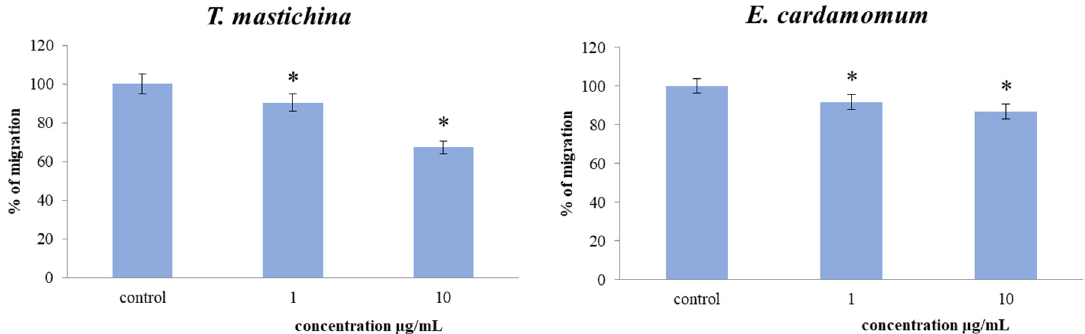
Figure 4. Effect of exposure to investigated essential oils on migration index of MDA-MB-468 cells. The cells were treated at concentrations of 1 µg/mL and 10 µg/mL over 72 h exposure and compared to nontreated control cells. Results are presented as the mean of three independent experiments ± standard error; * p < 0.05 relative to control.